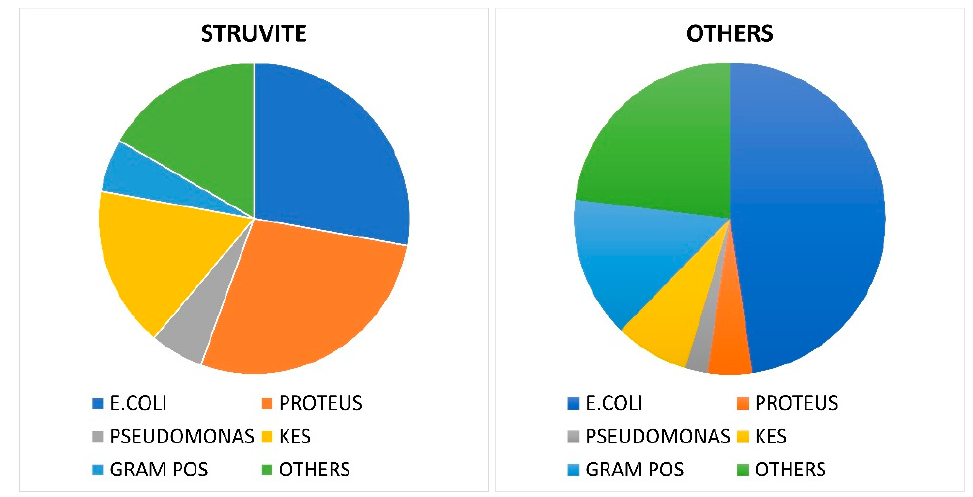
Figure 4. Bacterial spectrum of urine of patients with struvite stones (>50%) and other stones of metabolic origin.